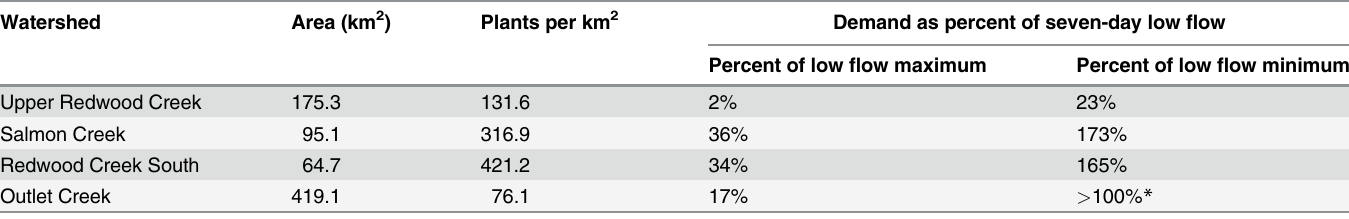
* The seven-day low fl ow minimum was measured as 0.0 CMS at the